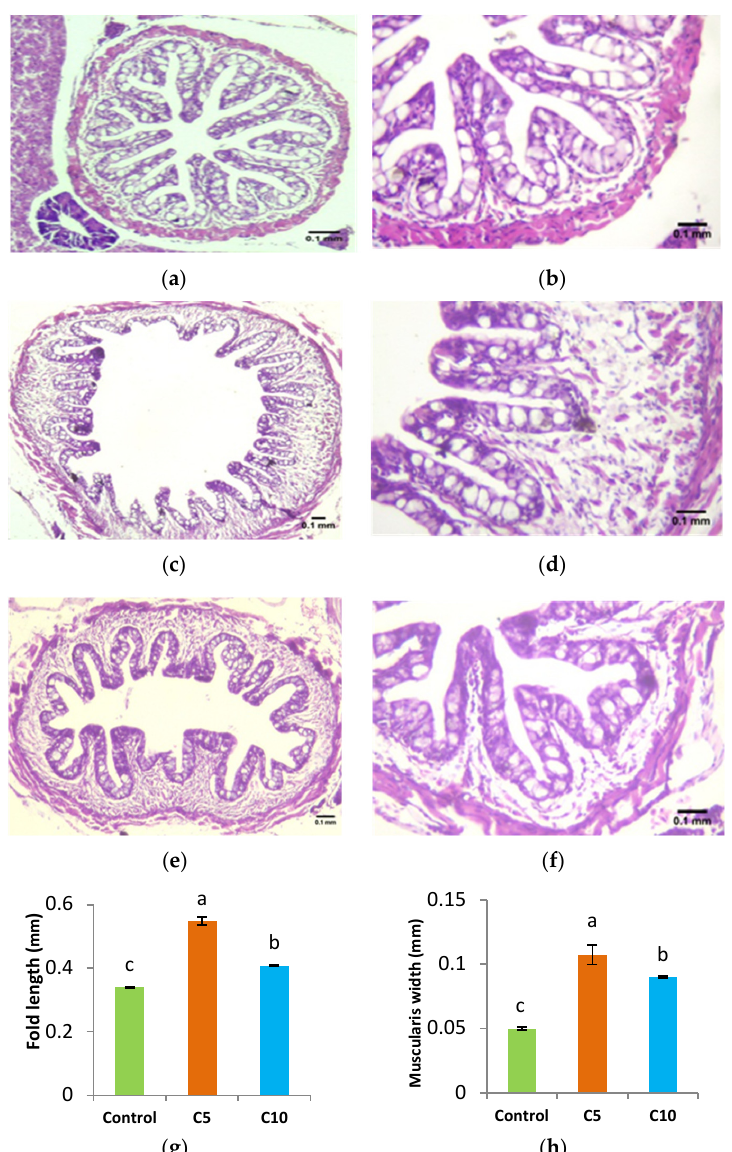
Figure 2. Histological variations ( a – f ) in the esophagus folds among trial groups. ( a , b ) Control; ( c , d ) C5; ( e , f ) C10 showing normal esophagus folds in all groups. Photos ( b , d , f ) are a magnification of ( a , c , e ), respectively (H&E staining, scale bar; 0.1 mm). Histograms ( g , h ) illustrate the variations in red tilapia esophagus folds length ( g ) and muscularis width ( h ) among the different experimental groups. Means with different letters are different.